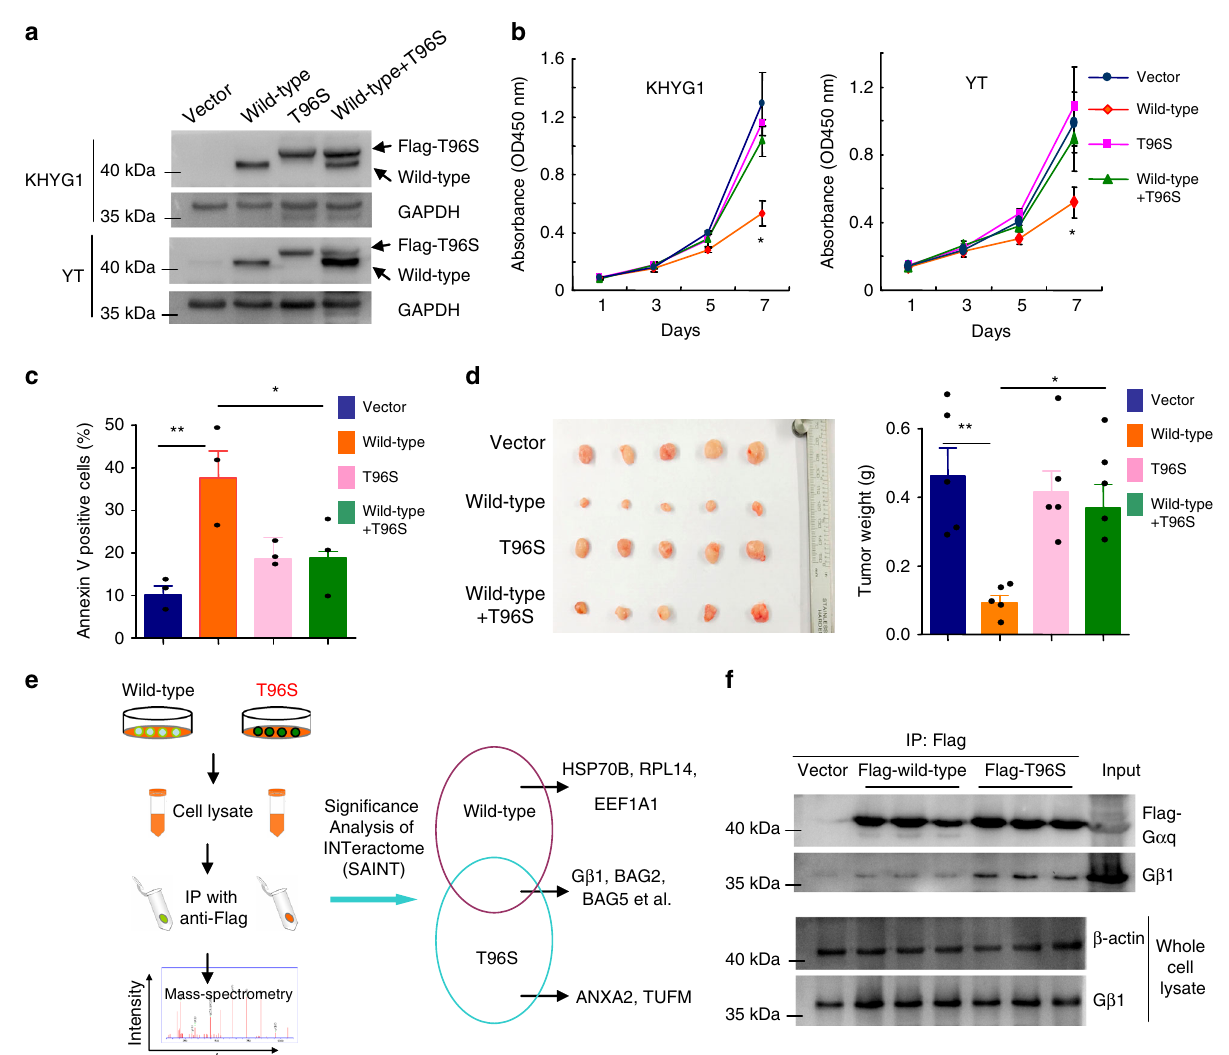
Fig. 5 G α q T96S mutant acts in a dominant negative manner to promote tumor growth of NKTCL. a Western blot shows that tetracycline-inducible cell lines (KHYG1 and YT) express equal amounts of wild-type and mutant G α q simultaneously. b Viability of YT and KHYG1 cells with inducible expression of vector, wild-type, T96S or wild-type plus T96S. Cell viability is presented as the absorbance value at OD 450 nm. Data are representative of three independent experiments. c Apoptosis was induced after starving KHYG1 cells of IL-2 for 12 h and was assessed by Annexin V staining assay. Data are representative of three independent experiments. d Representative images of xenograft tumors (left) and tumor weights (right) for YT cells with inducible expression of vector, wild-type, T96S or wild-type plus T96S ( n = 5 in each group). e Schematic diagram of the approach used to identify G α q-interacting partners using immunoprecipitation in combination with mass spectrometry. Signi fi cance analysis of INTeractome (SAINT) expression was utilized to calculate the probability of protein – protein interactions from background, nonspeci fi c interactions. The right panel shows representative binding proteins identi fi ed by mass spectrometry. f Con fi rmation of the interaction of wild-type G α q or G α q T96S mutant with G β 1 by immunoprecipitation assay. The G α q T96S mutant bound G β 1 more tightly than wild-type G α q in YT cells. All data are expressed as the mean ± s.e.m.; NS, not signi fi cant. * P < 0.05, ** P <